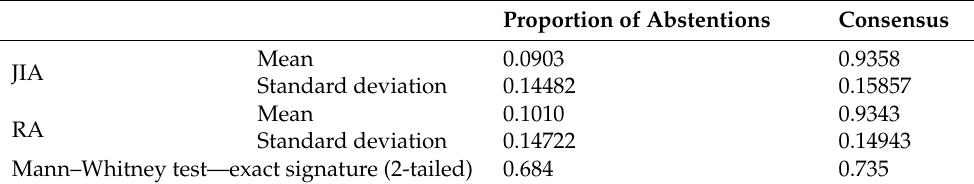
Table 8. Proportion of abstentions and consensus.